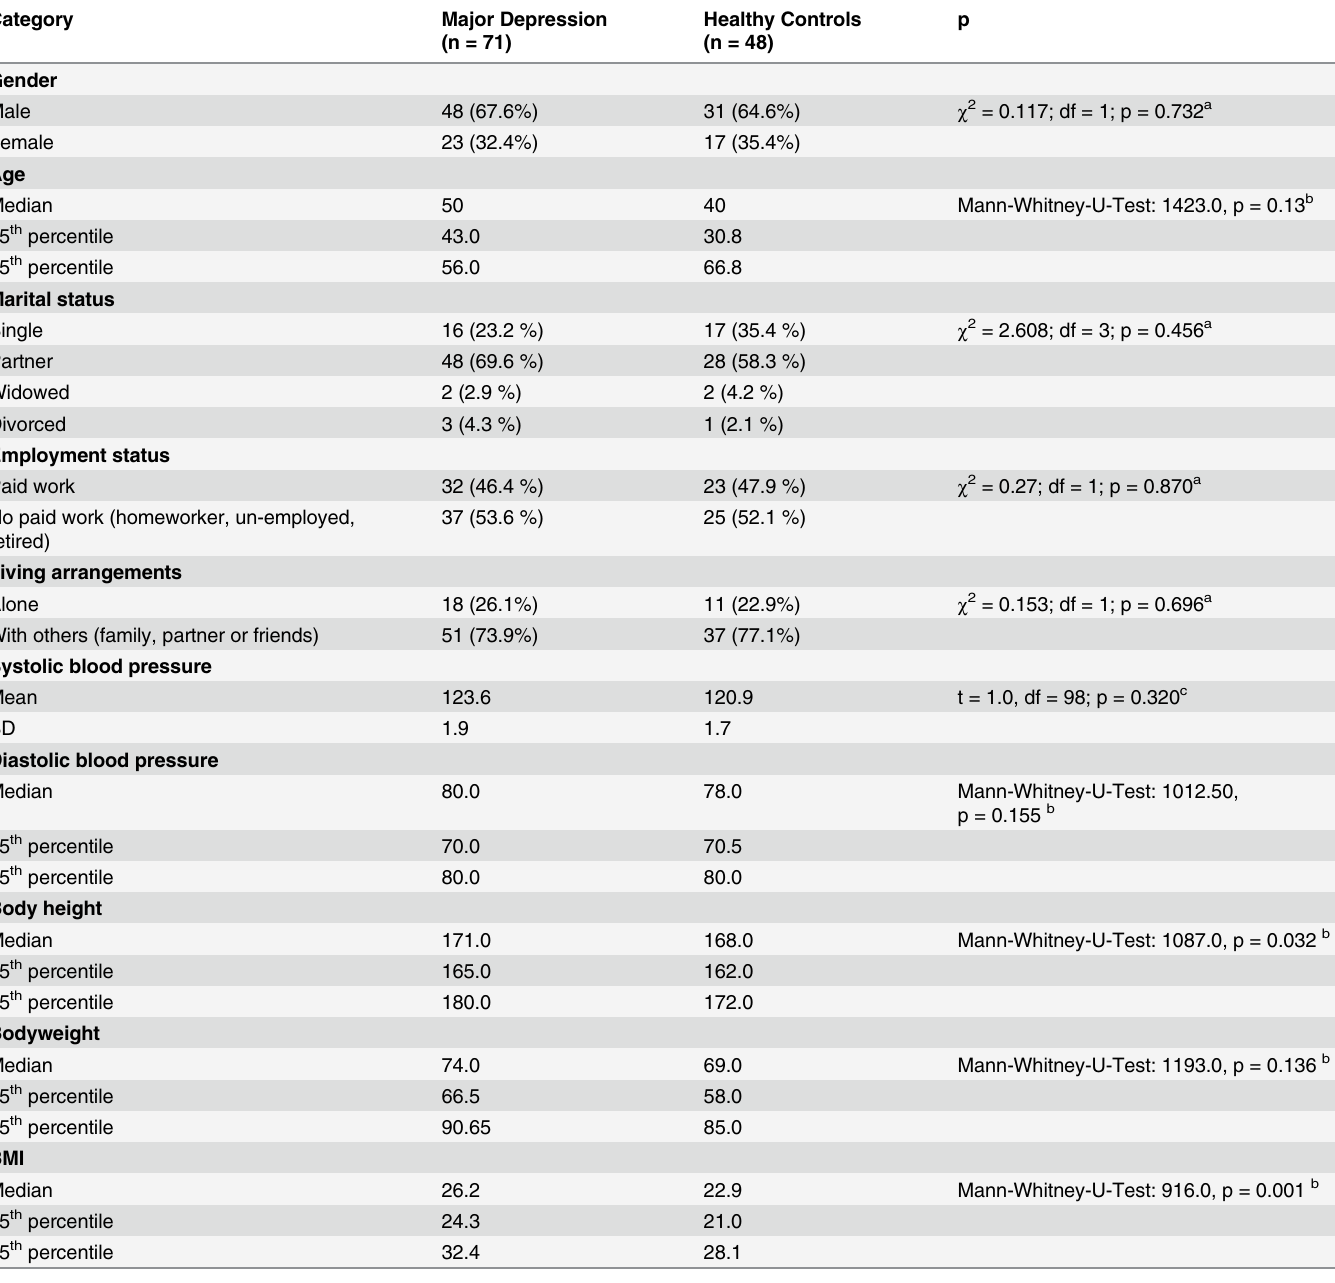
Table 1. Sociodemographic and clinical